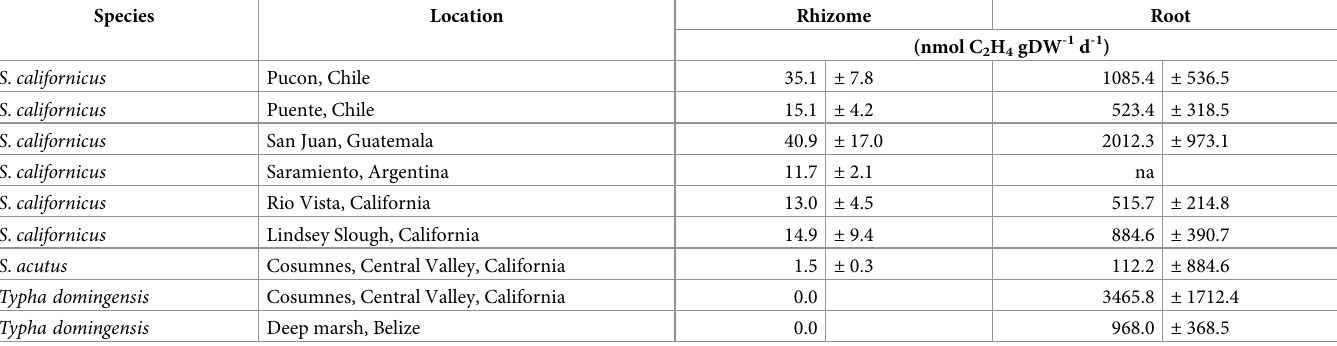
Table 3. Means ± standard deviation of nitrogenase activity measured as ethylene production of of epiphytic (roots) and endophytic (rhizomes) diazotrophs from Schoenoplectuscalifornicus , S . acutus and Typha domingensis